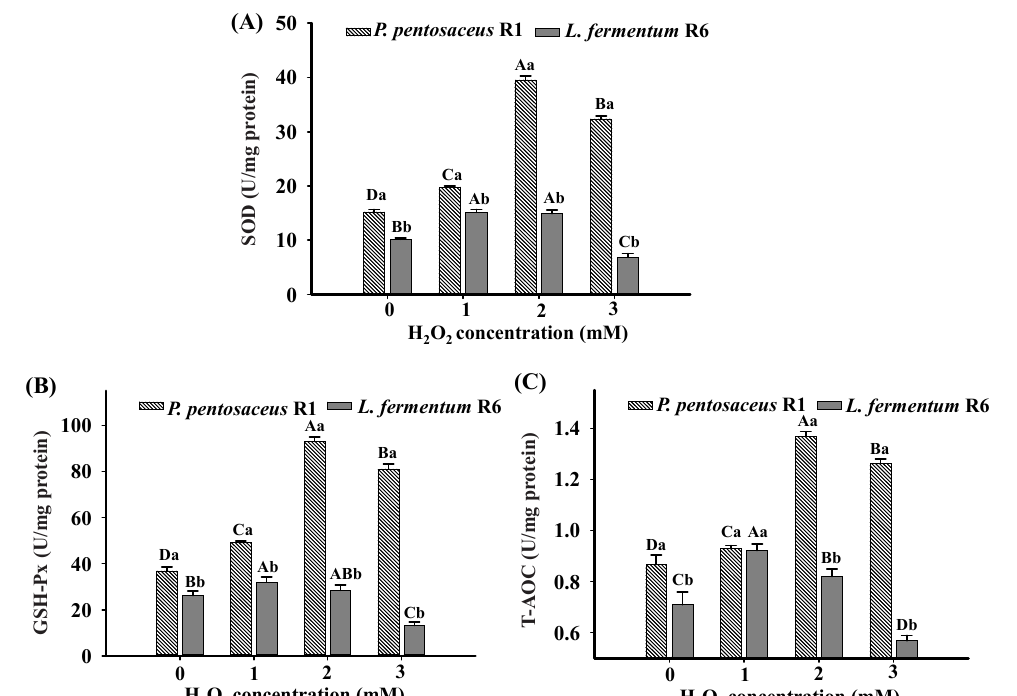
Figure 6. Superoxide dismutase (SOD) activity ( A ), glutathione peroxide (GSH-Px) activity ( B ), and total antioxidant capacity (T-AOC) (U/mg protein) ( C ) of Pediococcus pentosaceus R1 and Lactobacillus fermentum R6 after incubation in MRS broth with different H 2 O 2 concentrations for 1 h. Different uppercase letters (A–D) denote statistical differences ( p < 0.05) within the same strain under different H 2 O 2 concentrations; different lowercase letters (a and b) denote statistical differences ( p < 0.05) for both strains within the same H 2 O 2 concentration.